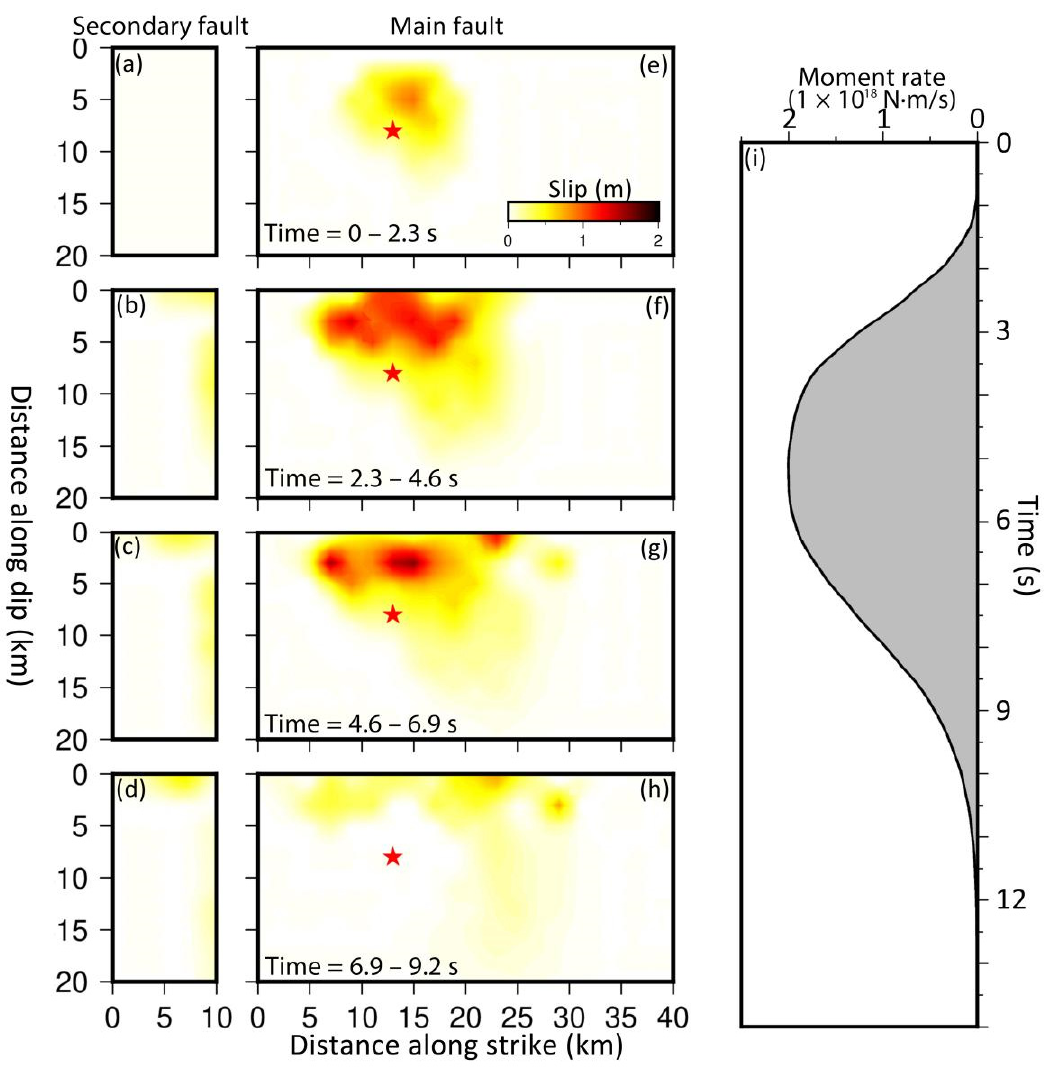
Figure 8. Rupture process in the first 9.2 s during the 2022 Menyuan earthquake. ( a – h ) Snapshots of the rupture process during sequential periods. Red stars indicate the hypocenter of the Menyuan earthquake. ( i ) Source time function showing the evolution of moment rate over time.